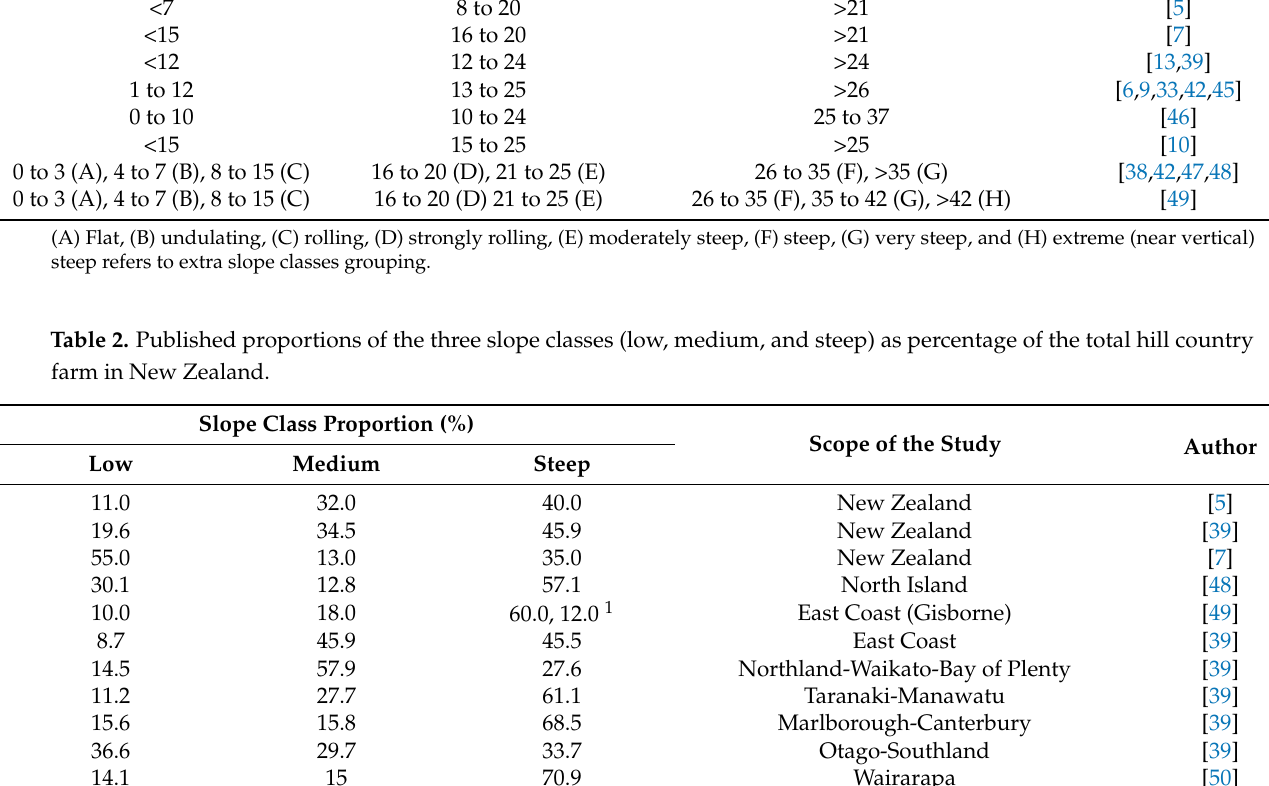
Based on published data, the slope types of the modelled North Island hill country sheep and beef farm were grouped into low (<12 ◦ ), medium (13 ◦ to 25 ◦ ), and steep (>25 ◦ ) slope classes [33,42] to capture the critical slopes relevant to pastoral land use [38] and pas- ture production [43]. Slope classes were apportioned as 8.7%, 45.9%, and 45.4% in the low, medium, and steep slope classes, respectively, and were used to reflect the average slope mix of East Coast hill country farms [39], Table 2. The model assumed that approximately 10% (56.4 ha) of the total effective land area of the farm would be used for planting native shrubs. This area was assumed to be part of the steep slope (>20 ◦ ) portion of the farm due to its low carrying capacity (herbage production) and vulnerability to erosion [44]. Table 1. Published classifications of North Island sheep and beef hill country farm slopes based on slope classes (low, medium, and steep). Slope Elevation ( ◦ ) Author (s) Low Medium Steep